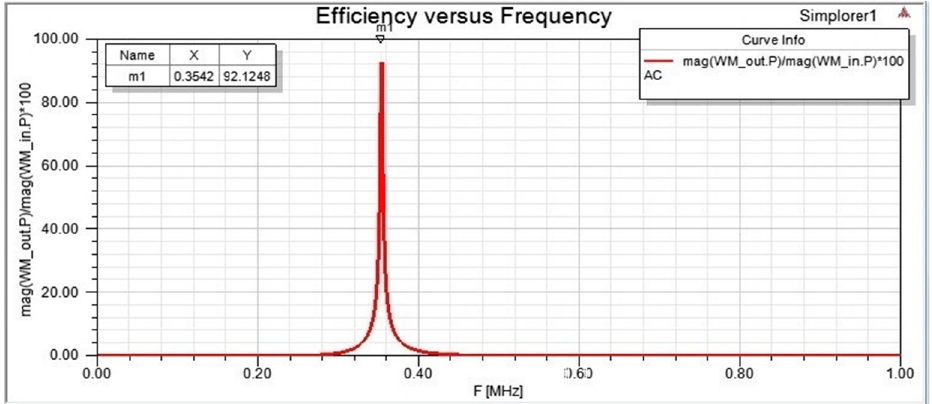
Figure 6. Mutual inductance between transmitter and receiver coils.